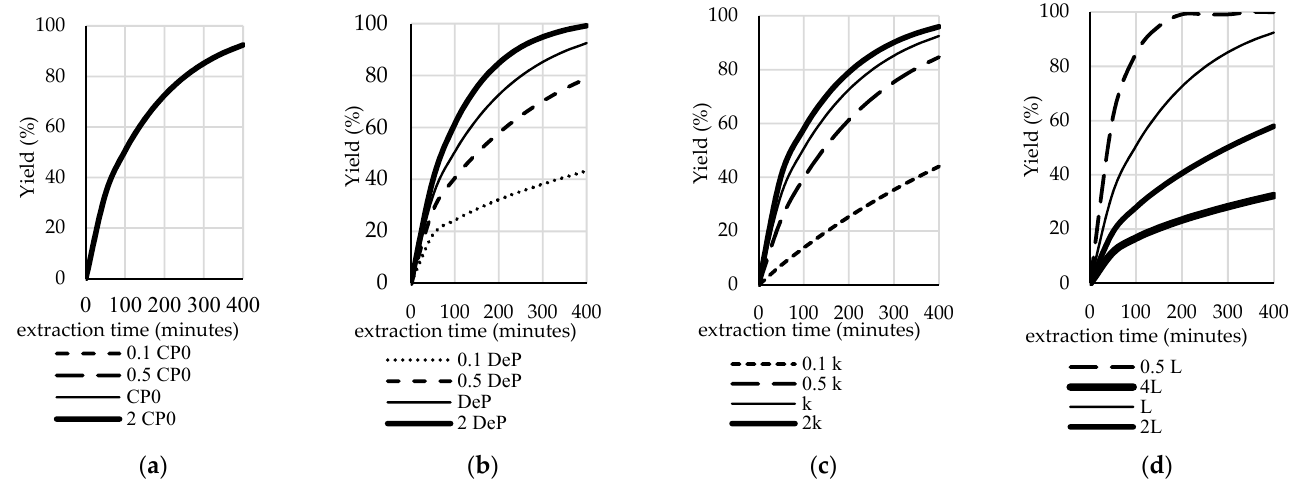
Figure 6. The effect of the: ( a ) initial P concentration in the pericarp; ( b ) effective diffusivity; ( c ) mass transfer coefficient; and, ( d ) slab thickness on the yield of the Figure 6. The e ff ect of the: ( a ) initial P concentration in the pericarp; ( b ) e ff ective di ff usivity; ( c ) mass transfer coe ffi cient; and, ( d ) slab thickness on the yield of extraction. the